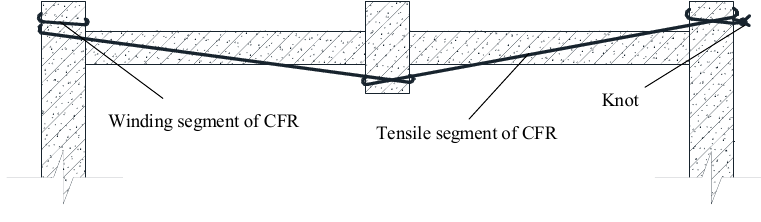
Figure 8. Way of CFR winding.